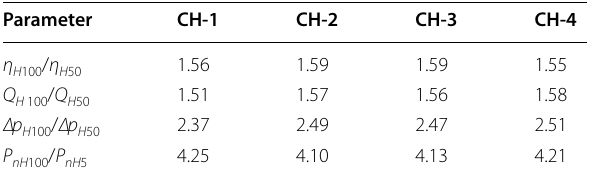
Table 3 Effect of increasing wave height from 50 mm to 100 mm on device performance parameters (presented as a